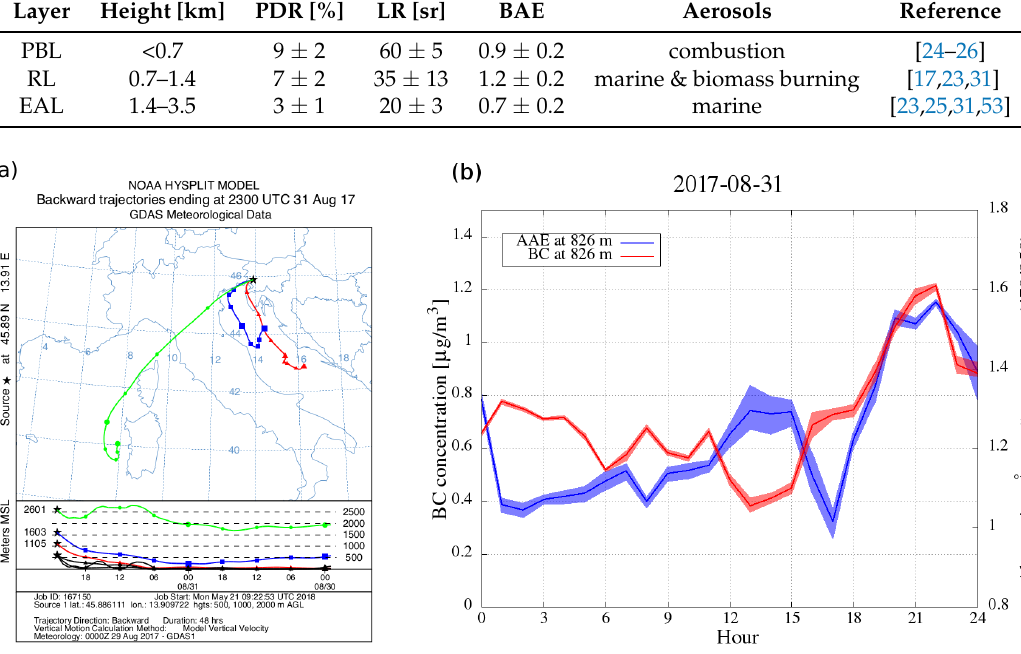
Figure 6. ( a ) HYSPLIT modeled 48h airmass backward trajectories for Ajdovšˇcina on 1 September 2017 at 00:00 CET (UTC+1). At higher altitudes (green), the trajectories mainly originated above the Mediterranean, while at lower altitudes (blue and red) they originated above the Adriatic. ( b ) Daily evolution of BC concentrations (red) and aerosol AAE (470/950) (blue) at Otlica on 31 August 2017. The data was sampled in one-minute intervals and averaged over 30min. Error bars denote the averaging